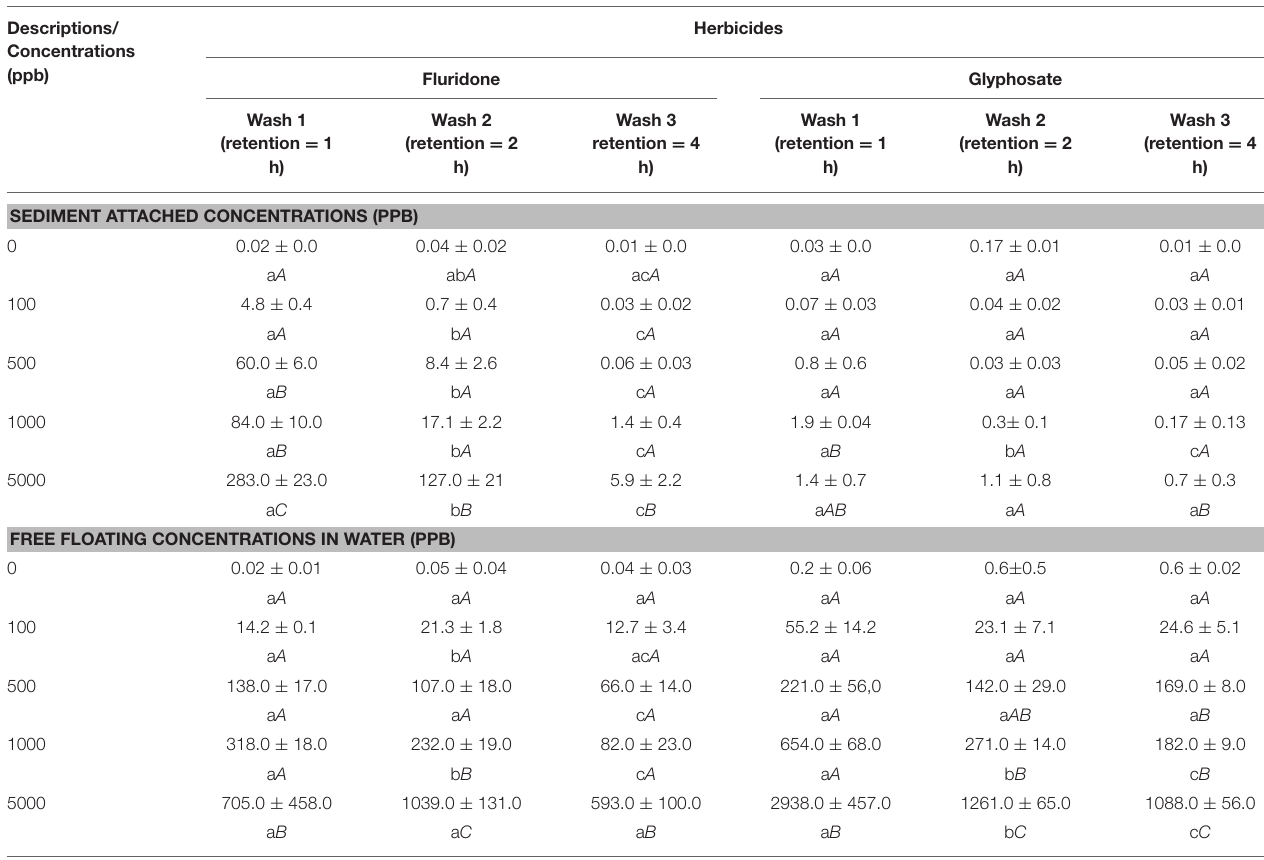
TABLE 1 | Determination of Fluridone and Glyphosate concentrations (ppb) in sediment and water after consecutive washes. Descriptions/